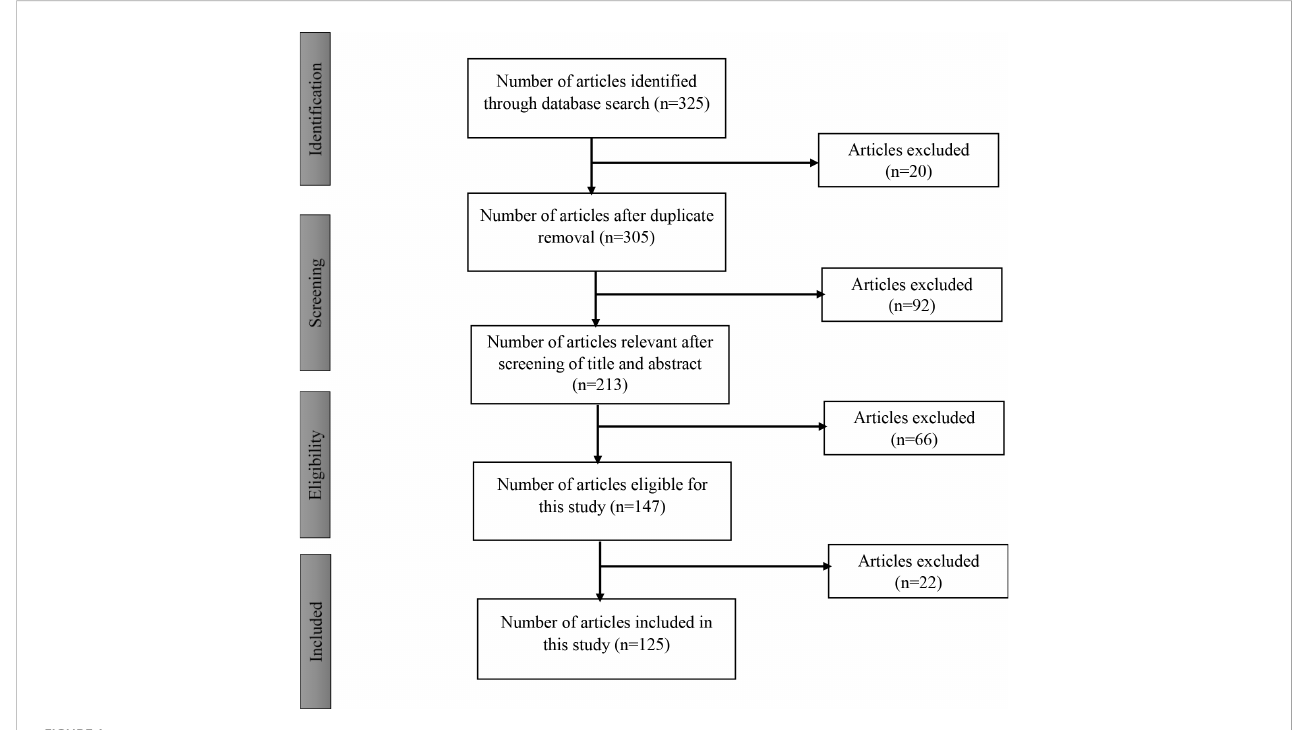
FIGURE 1 Flow diagram for selection of